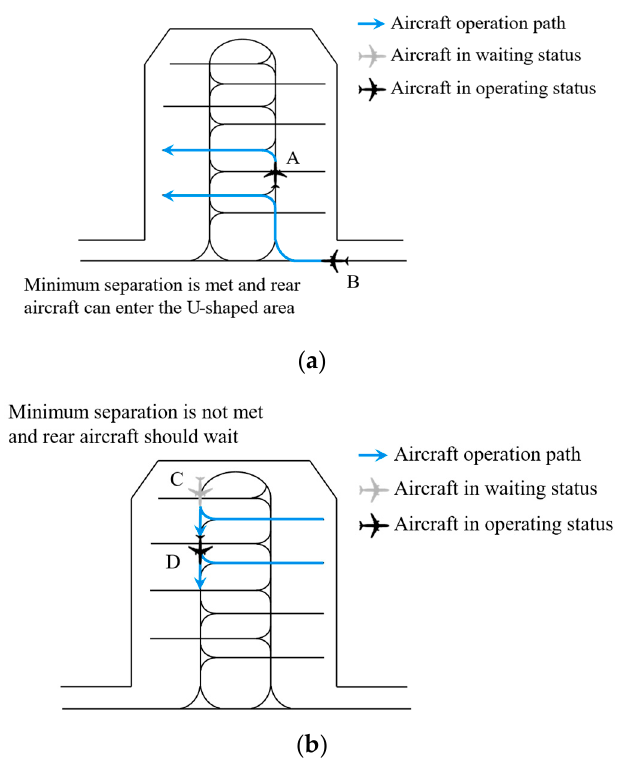
Figure 6. Global-Shared Operation Procedure. ( a ) shows a scenario that arrival aircraft B follows departure aircraft A into the U-shaped area; ( b ) shows a scenario that departure aircraft C follows departure aircraft D leaves the U-shaped